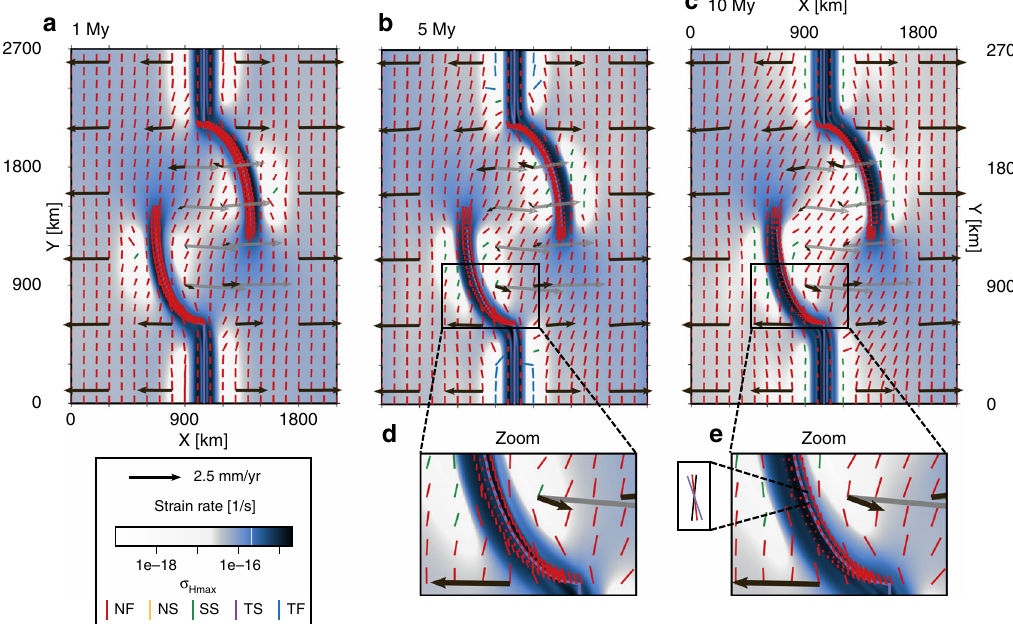
Fig. 3 Generic mobile belt con fi guration reference model Ellipse 90 ∘ results. a – e Depicted are the strain rate fi eld, maximum horizontal compressive stress σ colored according to the tectonic regime, and the velocity vectors at 3-km depth at 1, 5, and 10 My. High-resolution σ Hmax plotted in an area of 100 km around the mobile belt axes if the strain rate exceeds 1 × 10 − 16 s − 1 . Black vectors are plotted in the model frame of motion, while the dark-gray vectors represent the microplate motion in a Nubia- fi xed frame. Black and gray vectors are scaled equally. Panels d and e show a zoom- in of the oblique rift section in the boxed area indicated in b and c , respectively. The inset in e illustrates characteristic local deviations from far- fi eld kinematics by comparing σ (red), rift trend (purple), and the orthogonal of the local extension direction (black). NF normal faulting, NS normal and Hmax strike – slip faulting, SS strike – slip faulting, TS thrust and strike – slip faulting, TF thrust